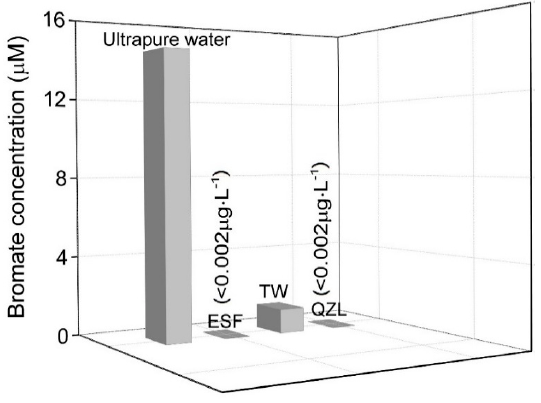
Figure 9. Formation of bromate in three real waters treated by PMS/BiOBr. BiOBr dose 1.0 g ∙ L − 1 , [CBZ] 0 = 5 μ M, [PMS] 0 = 4.0 mM, pH = 7.0, T = 24 °C.